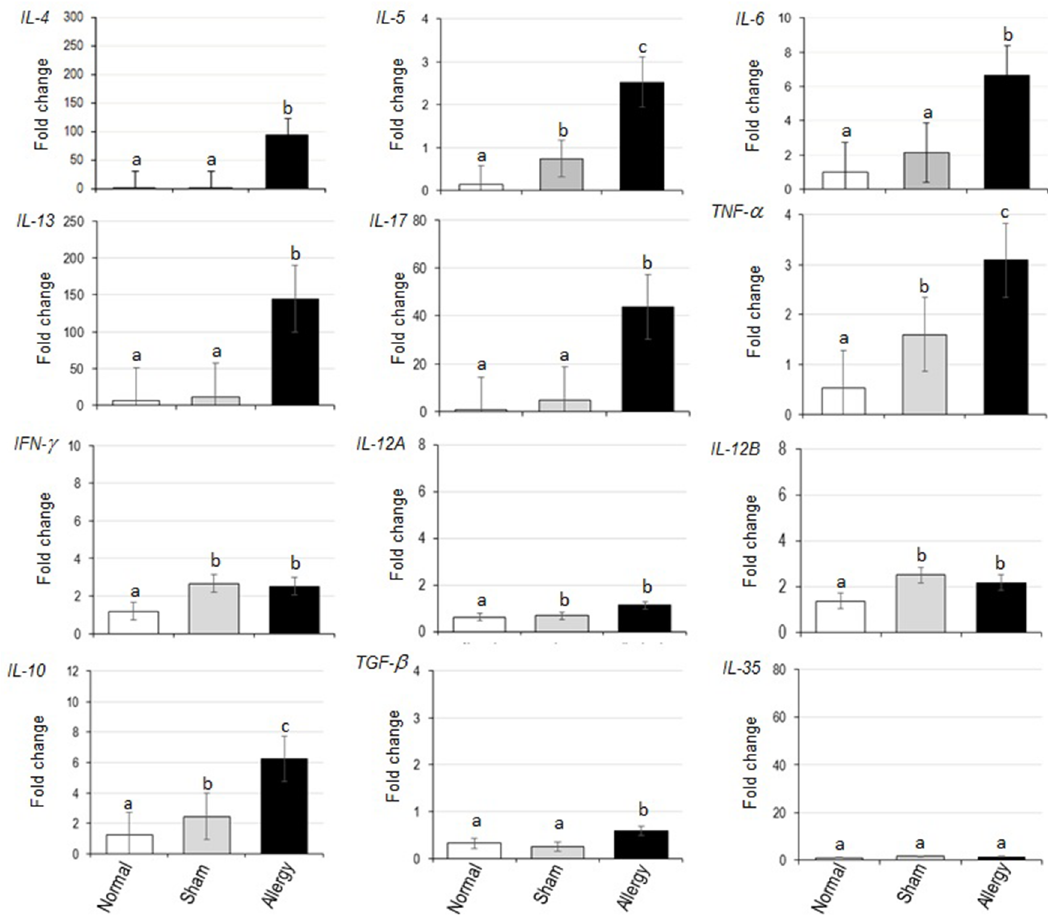
Fig 4. Cytokine expression profiles of normal, sham and allergenized